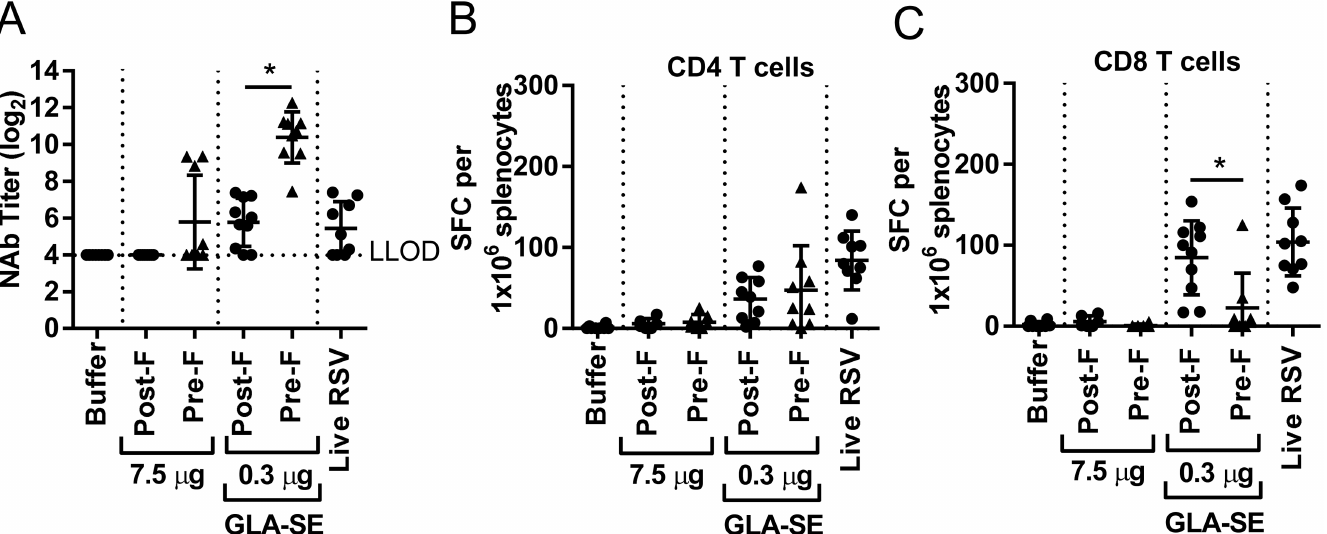
Fig 5. Immunogenicity of post-F and pre-F in aged seronegative mice. Aged (18 months old) BALB/c mice (n = 6 to 10 per group) were immunizedi.m. at day 0 and day 21 with buffer alone, RSV F (pre- or post- conformation) at the indicateddoses +/- GLA-SE (2.5 μ g/2%) adjuvant. A control group for natural infection was immunized i.n. with live RSV (10 6 PFU) at day 0. At day 35, animalswere challengedi.n. with 10 6 PFU of wt RSV A2. Prior to challenge (day 34), sera were harvested and NAb titers were evaluatedusing a microneutralizationassay. Data is presentedas the log 2 dilutionof serum that provides 50% reductionin viral entry with a LLOD of 4 indicatedby a dashed line. 4 days post-RSV A2 challenge, splenocyteswere isolated and stimulatedfor 24 h with peptides representing (B) RSV F specific CD4 T cell and (C) CD8 T cell epitopes.The number of IFN γ secretingcells per 10 6 splenocyteswas determinedby ELISPOT. Group means ± SD of individualmice are shown. For statistical analyses,aged and young mice were compared. * , P < 0.05.